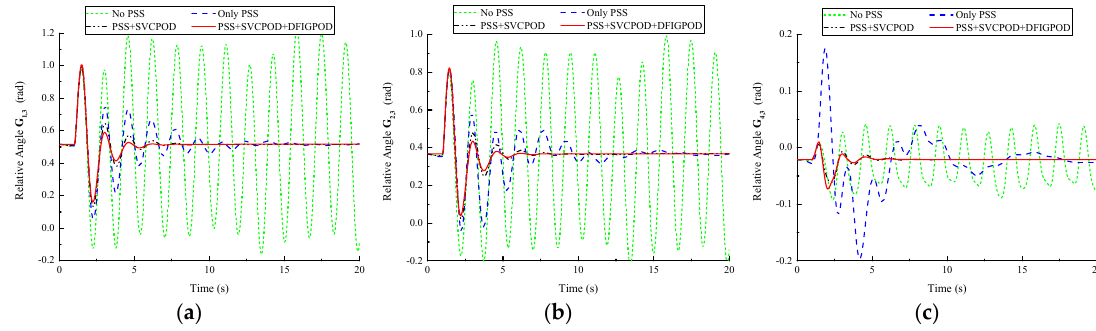
Figure 10. System bus 7 3-phase fault responses under light inter-area power flow transmission condition. ( a ) Relative power angle of generator G1 and G3; ( b ) Relative power angle of generator G2 and G3; and ( c ) Relative power angle of generator G4 and G3.